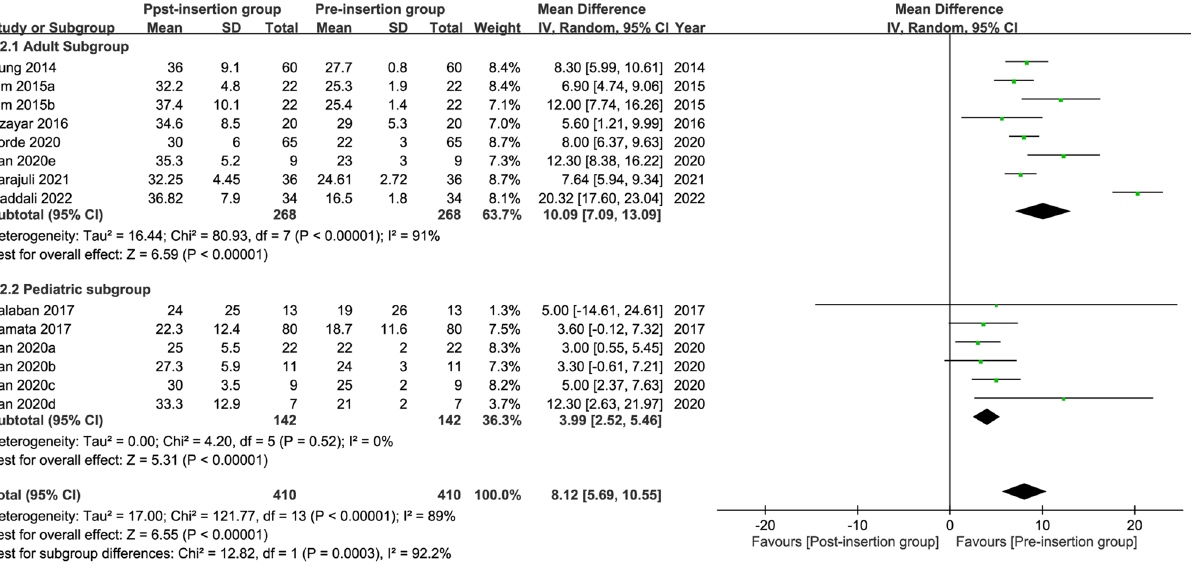
Figure 6. Forest plot for the comparison of changes in cuff pressure after esophageal medical device insertion. CI confidence interval; IV inverse